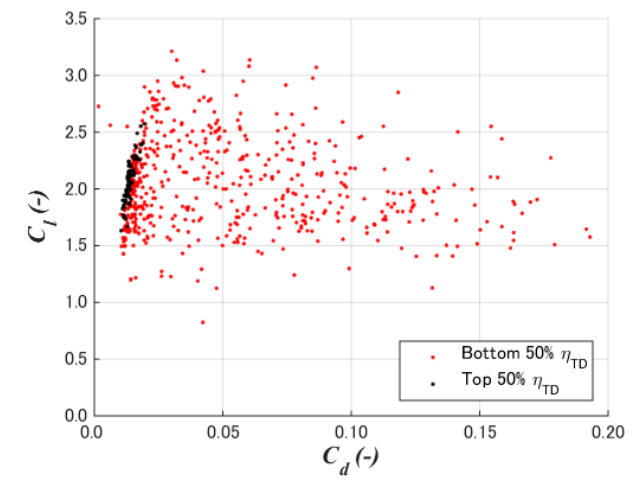
Figure 12. Lift coefficient to drag coefficient.